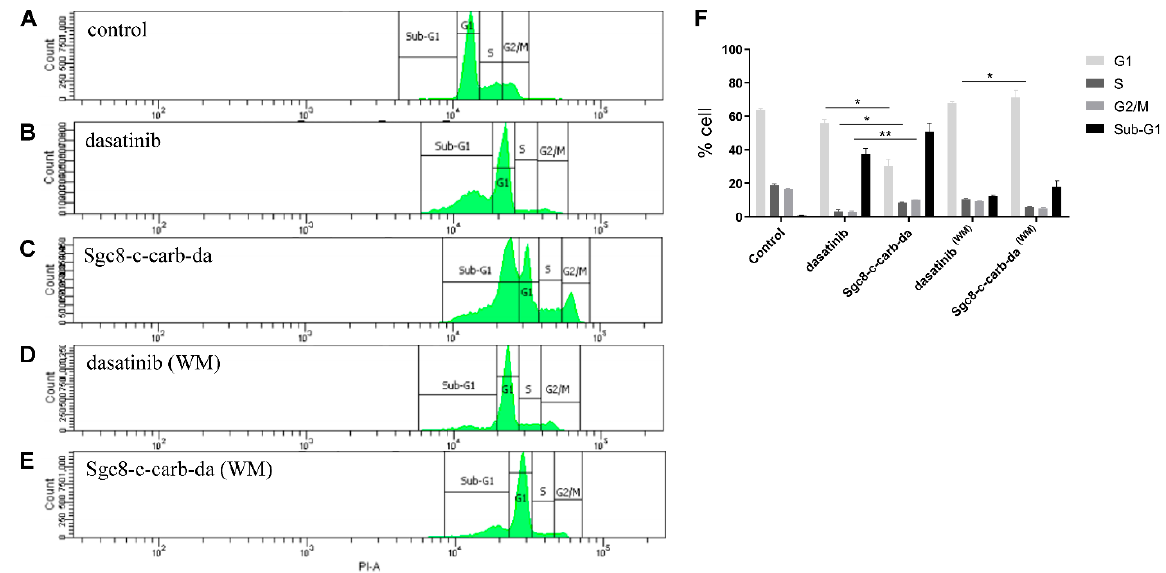
Figure 7. Analysis of cell cycle phases. Assay was performed on A20 cells after incubation with 800 nM Sgc8-c-carb-da and dasatinib for 24 h, with (WM) or without the washing method (60 min of drug exposure followed by a wash and further incubation). Histograms of cells incubated with ( A ) control culture medium, ( B ) dasatinib for 24 h, ( C ) Sgc8-c-carb-da for 24 h, ( D ) dasatinib for 60 min then washed, and ( E ) Sgc8-c-carb-da for 60 min then washed. ( F ) Percentages of cells in the different cell cycle phases after incubation under the mentioned conditions. Graph shows mean ± SD, n = 3 per condition. * p < 0.05, ** p < 0.01 (Student’s t